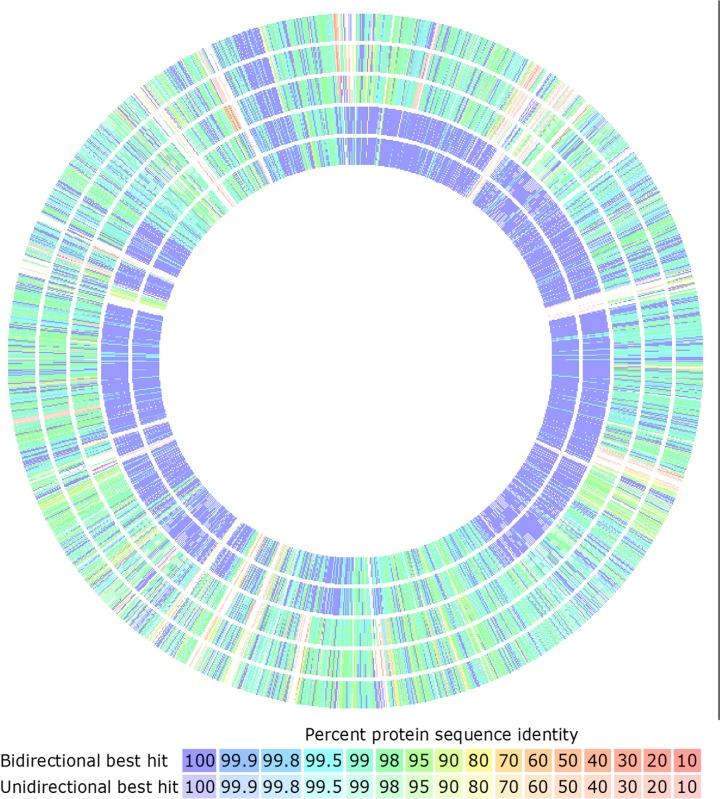
Comparison of Predicted EC Proteins.Protein sequences were compared using the RAST SEED viewer sequenced-based comparison tool with SA3 used as the reference sequence. The inner two rings are SA1 and SA2, while the outer three rings are CE1, CE2, and CE3 respectively. Percent protein sequence identity is expressed by color coding provided in the legend. A threshold of 98% sequence identity was used to identify sequences highly conserved in pathogenic strains compared to commensal strains. Using this threshold, a total of 414 predicted proteins were found to be highly conserved in pathogenic EC strains. The predicted function of these proteins and location on the SA3 chromosome are provided in S2 Table.